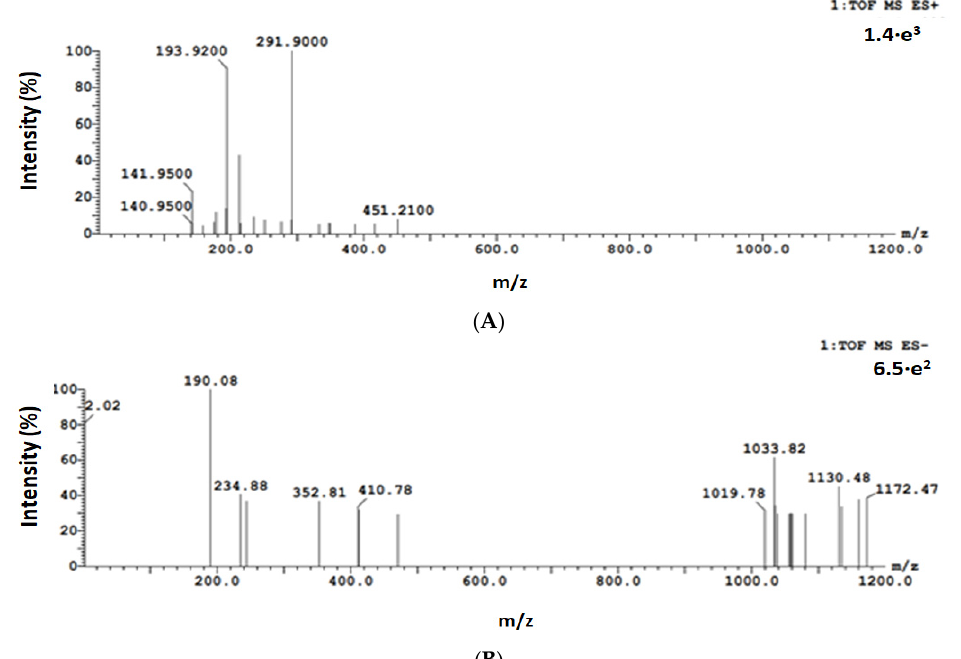
Figure 2. Mass spectra of hydrolysed products after 6 h of enzymatic reaction using Bacillus haynesii. chitinase in positive mode ( A ) and negative mode ( B ).